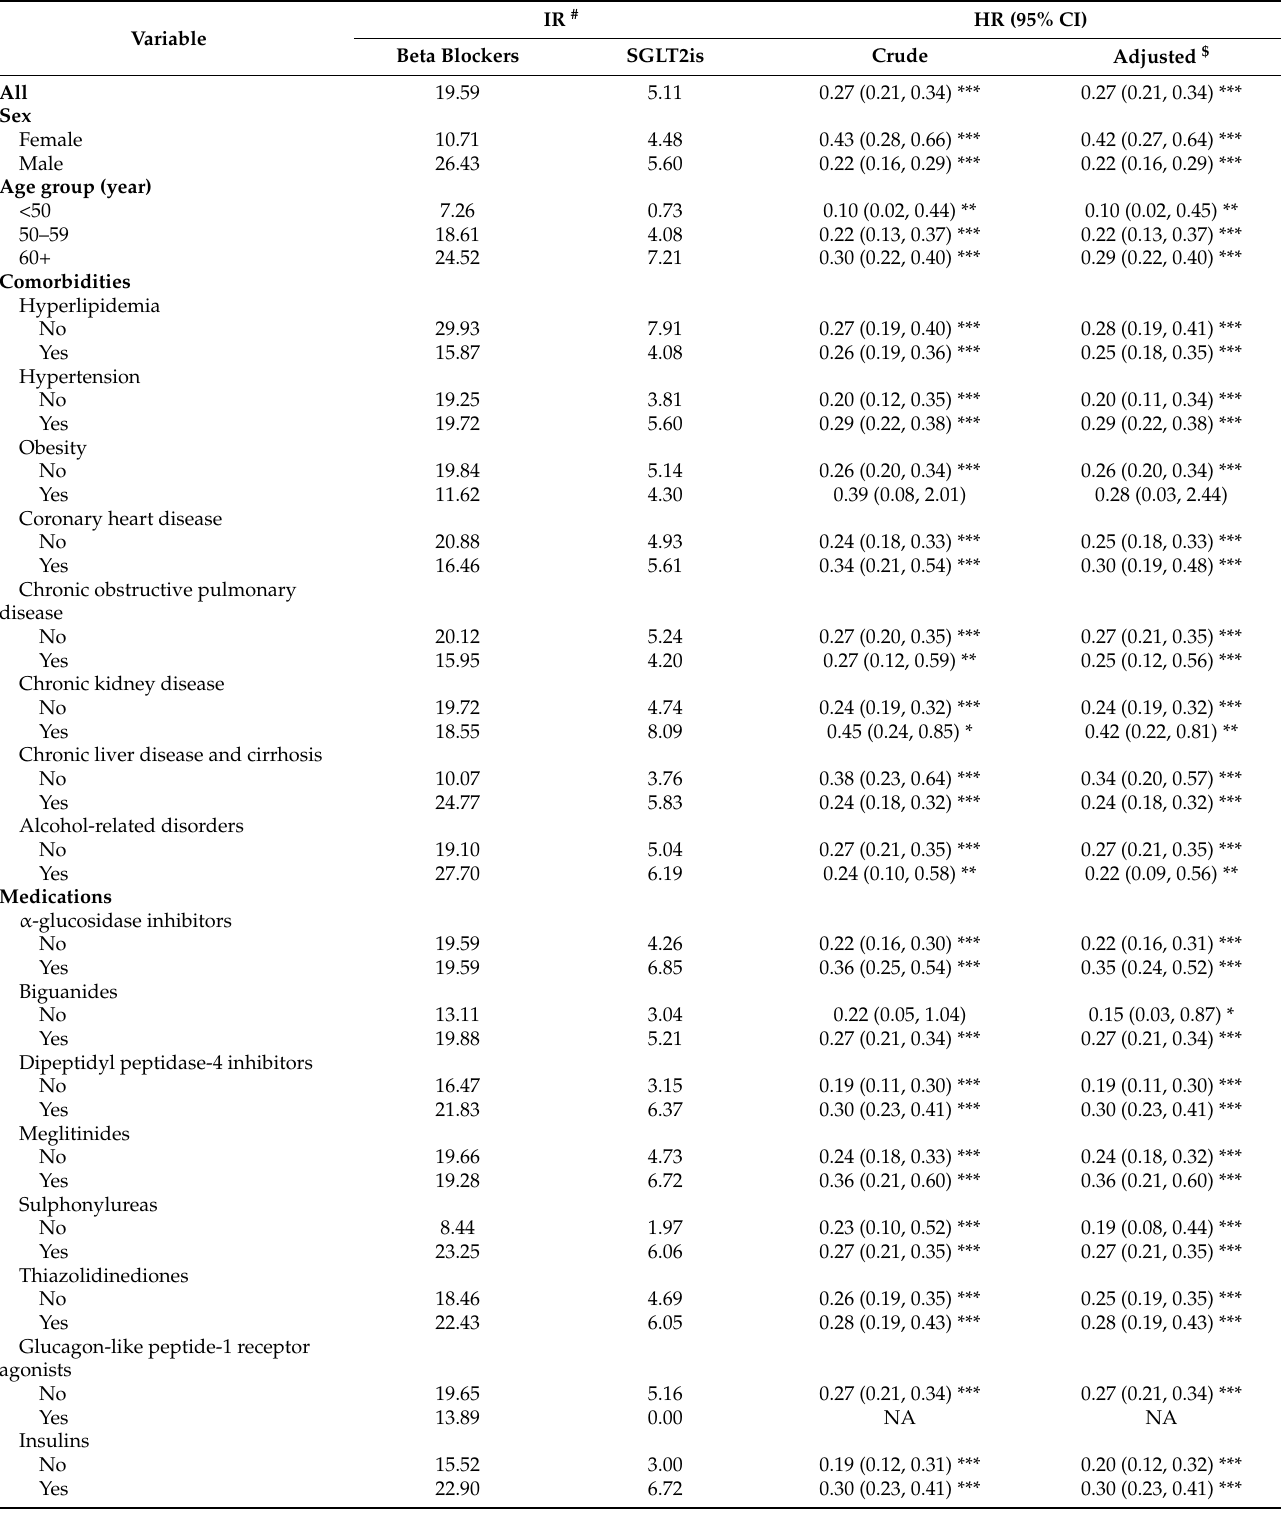
Table 2. Risks of HCC associated with SGLT2is in comparison with β -blockers among DM patients with HBV/HCV considering different baseline